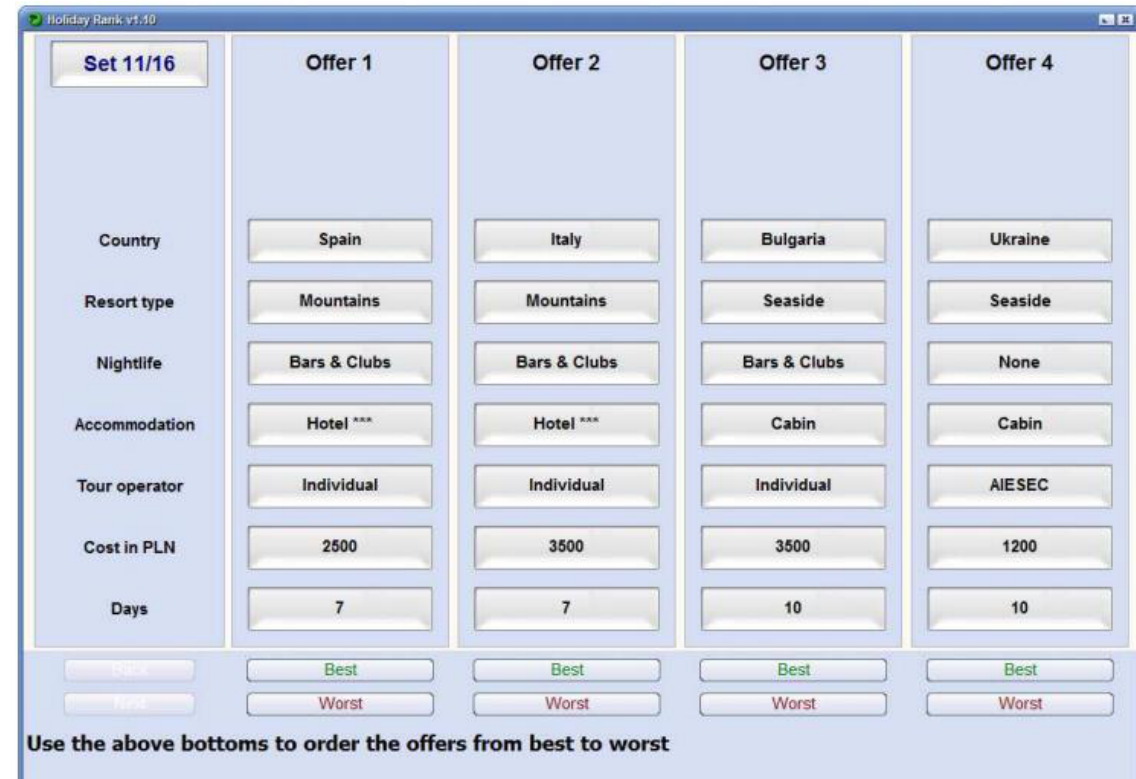
Figure 1. Example of choice scenario in the general holiday